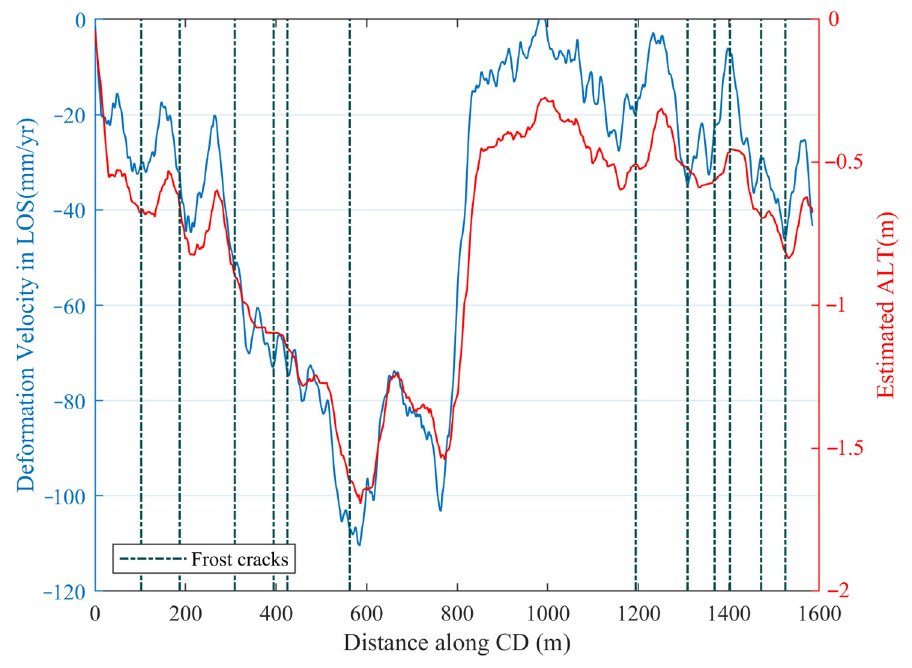
Figure 9. Deformation and ALT profile along